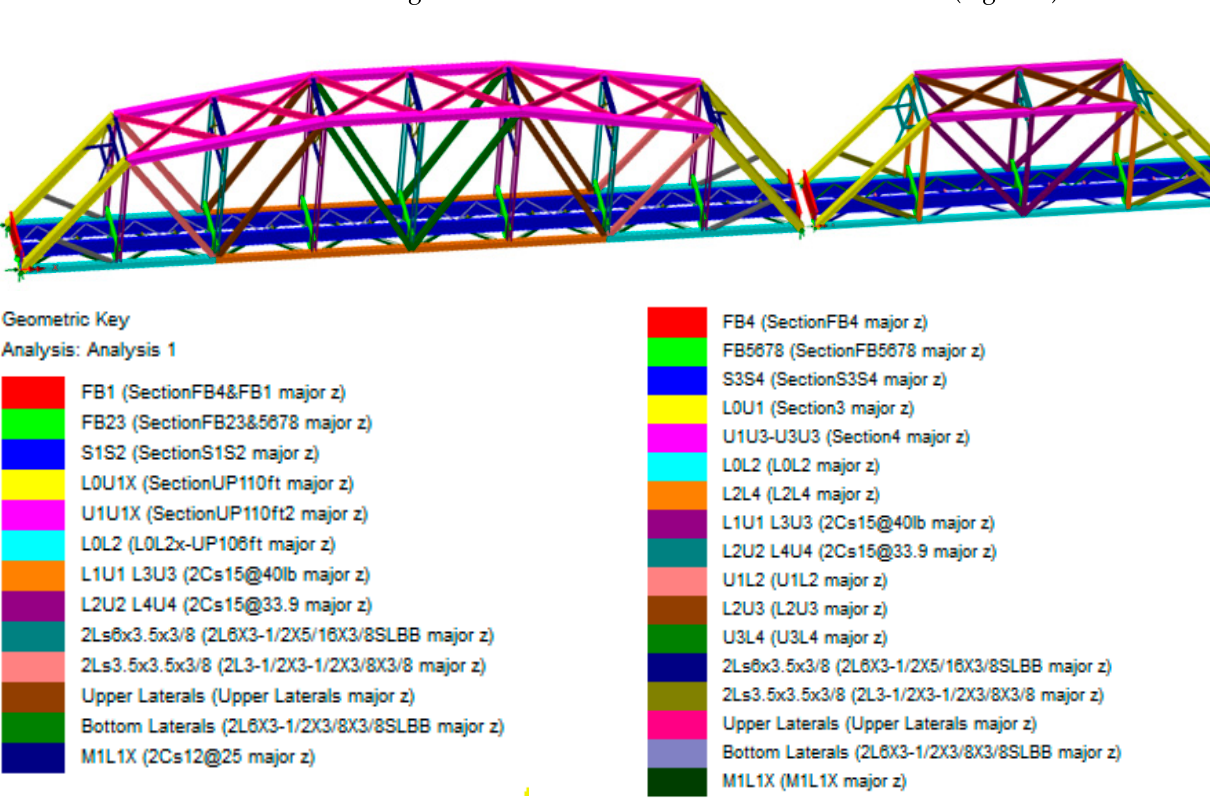
Figure 5. FEM model of investigated truss bridge.